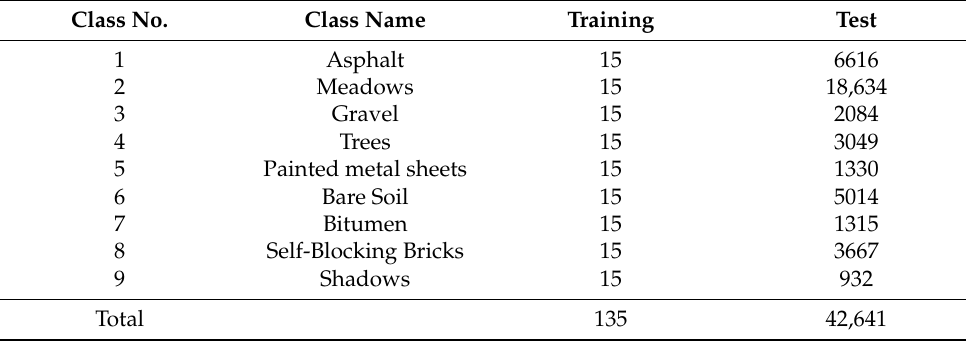
Table 5. The land cover category and data division on the Pavia University dataset. Class No.